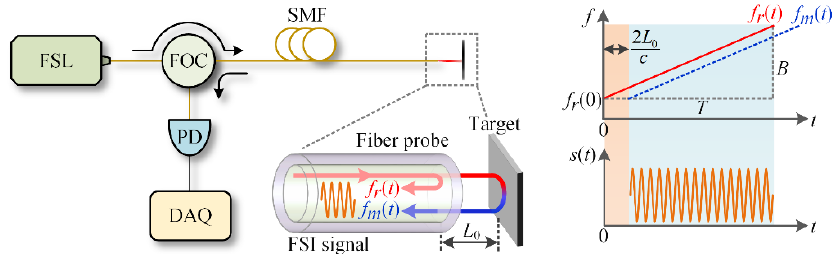
Figure 2. Schematic of the fiber-optic FSI system. (FSL: frequency-swept laser; FOC: fiber-optic circulator; SMF: single-mode fiber; PD: photodetector; DAQ: data acquisition system.).